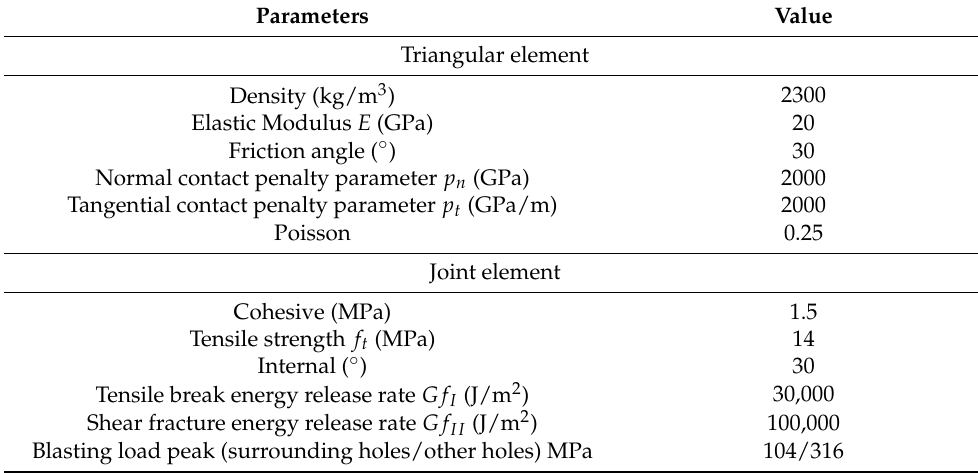
Figure 5. ( a ) Schematic diagram of blasting excavation construction process of the double side drift method; ( b ) schematic diagram of the blast hole arrangement and networked detonation in part VI. Table 1. Meso input parameters of MultiFracS for tunnel calculation